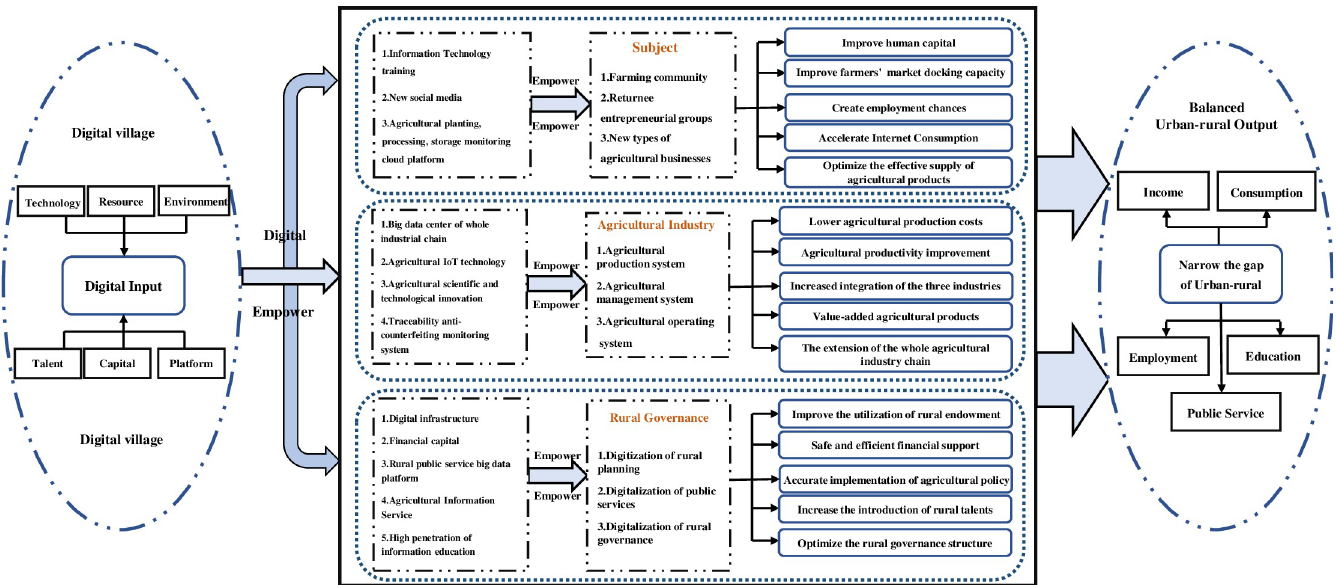
Fig 1. The mechanism of enabling urban-rural equilibrium.